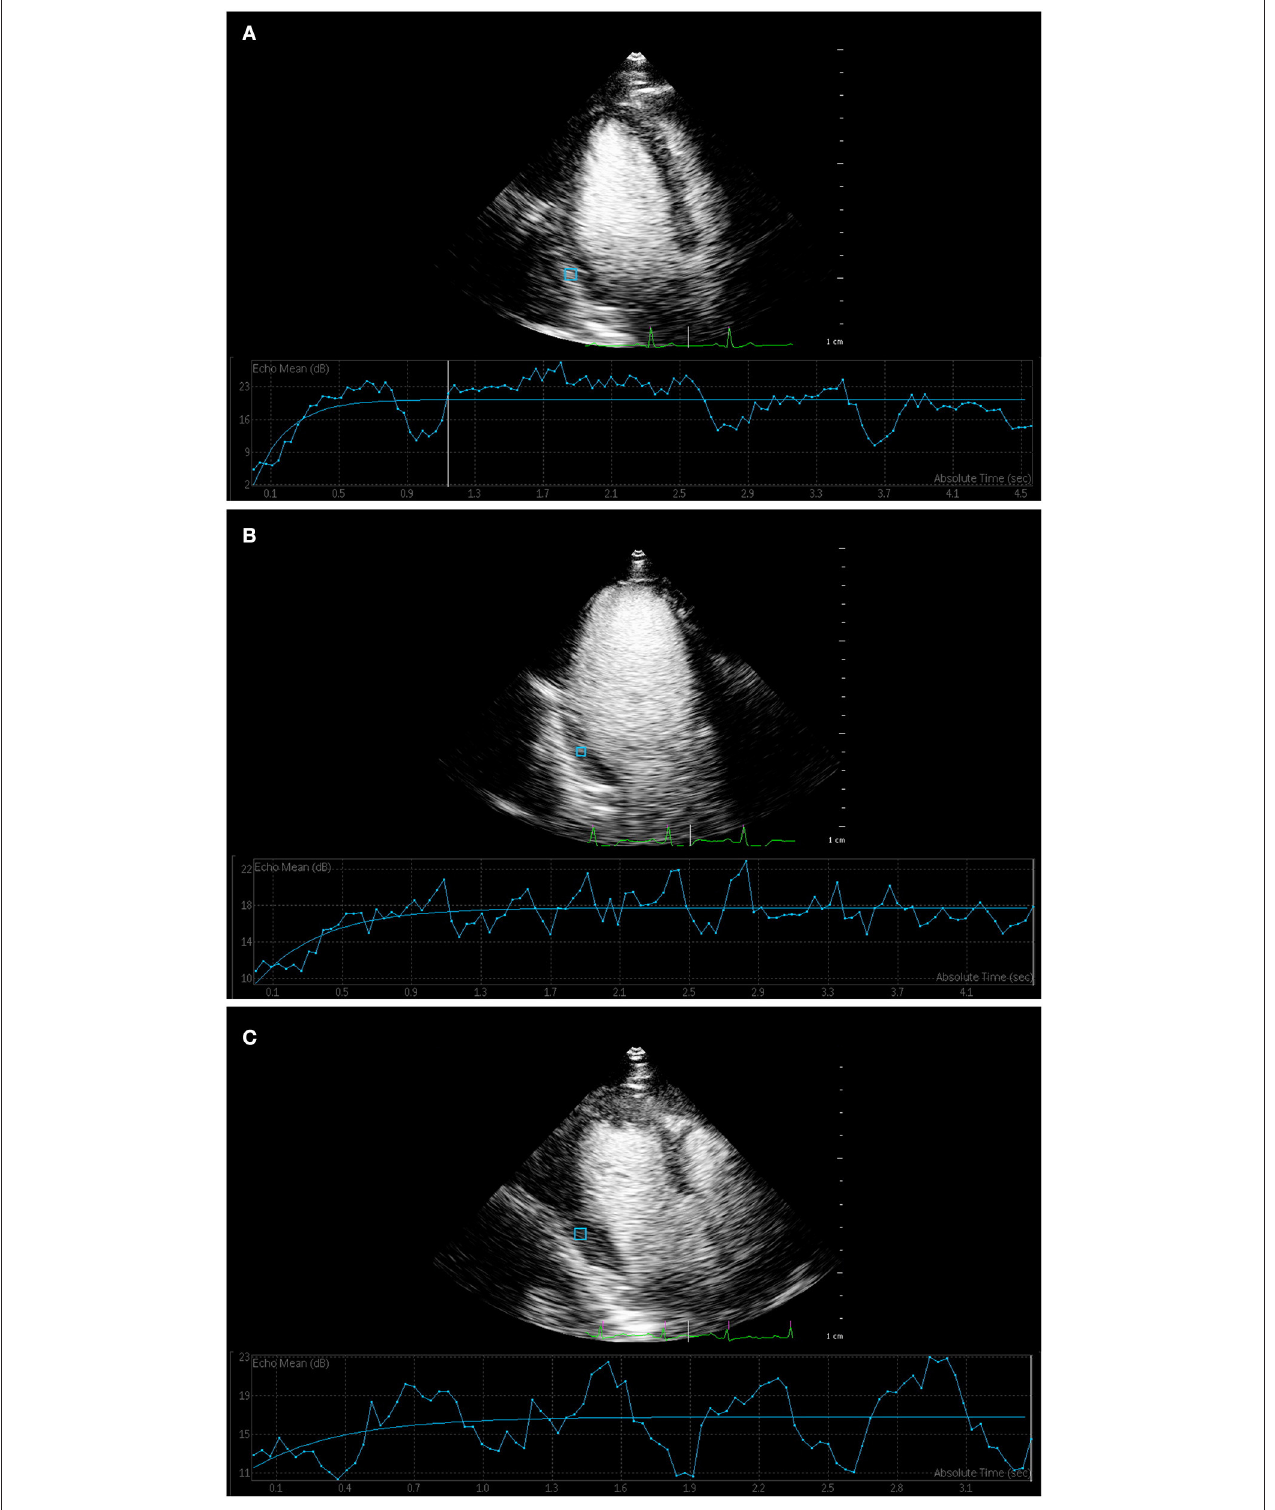
FIGURE 2 | Myocardial contrast echocardiography of myocardial perfusion. (A) Time–intensity curve showed that the curve of control group rose rapidly to the plateau stage, and the peak intensity was high. (B) Time–intensity curve of T2DM without microvascular complications group and (C) T2DM with microvascular complications group increased slowly, and peak intensity was lower than that of control group.